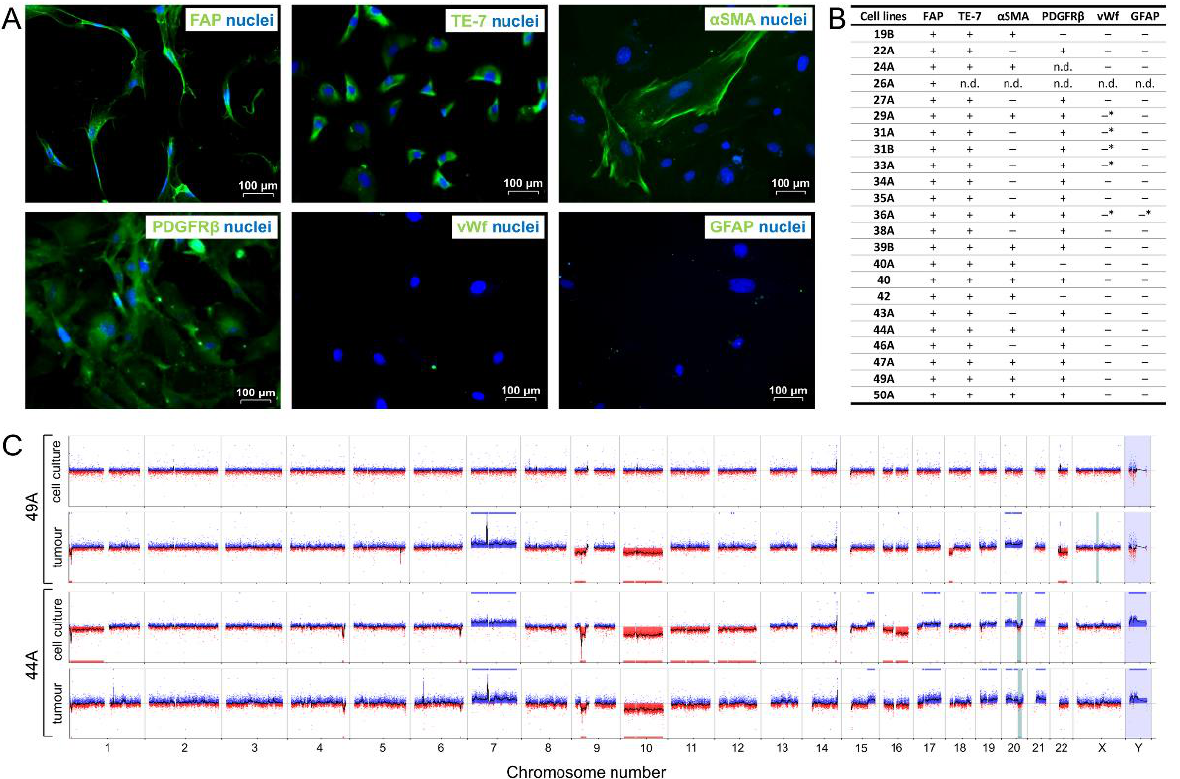
Figure 2. FAP + stromal cell cultures derived from human glioblastoma characteristically express mesenchymal markers and in most cases lack the genetic aberrations characteristic of glioma cells. ( A ) Immunocytochemical detection of mesenchymal (TE-7, α SMA, PDGFR β ), endothelial (vWf), and glial (GFAP) markers in FAP + mesenchymal cell cultures. ( B ) Summary of immunocytochemical analyses in FAP + cell cultures used for functional studies in this project; (+) positivity in most cells with the exception of α SMA, where only a subpopulation of cells was positive, (–) no positive cells detected. (–*) negativity in most cells with admixture of less than 2% of positive cells. ( C ) aCGH/SNP analysis of FAP + mesenchymal cell cultures and the corresponding tumour tissues. Cell culture 49A represents the dominant group of FAP + mesenchymal cell cultures without changes characteristic of glioblastomas, whereas 44A typifies the smaller group that bears aberrations similar to the corresponding tumour tissue. Losses of DNA copy number in red, gains of DNA copy number in blue. CN-LOH is indicated by a light blue